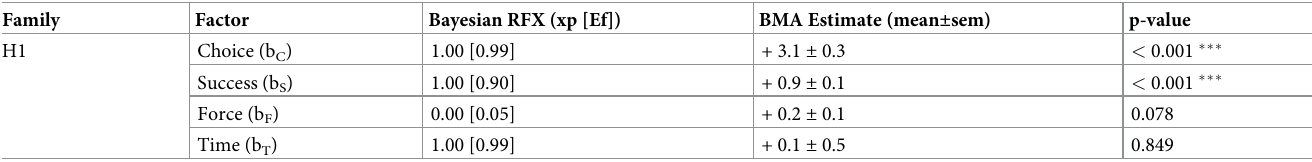
Table 1. Effects of action-related factors on subsequent desirability ratings.